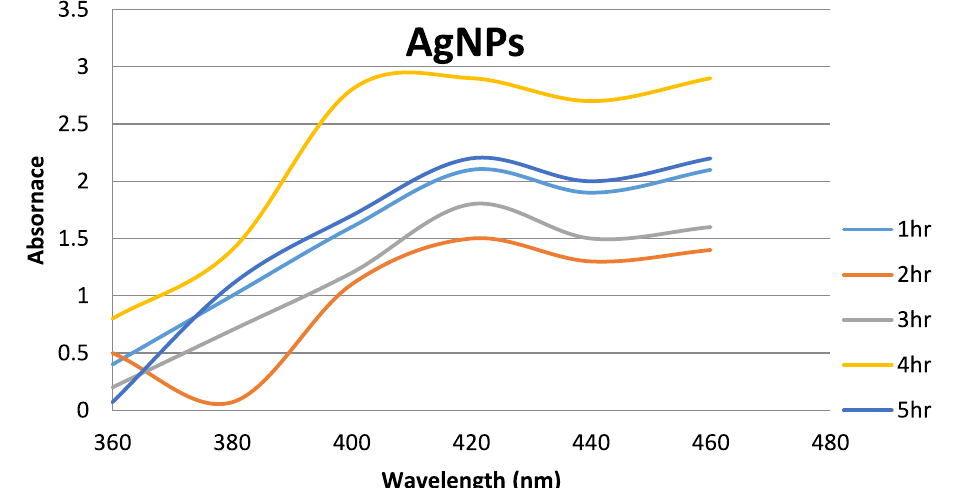
Fig. 2. UV-Vis Spectrometer analysis of Caryota urens silver